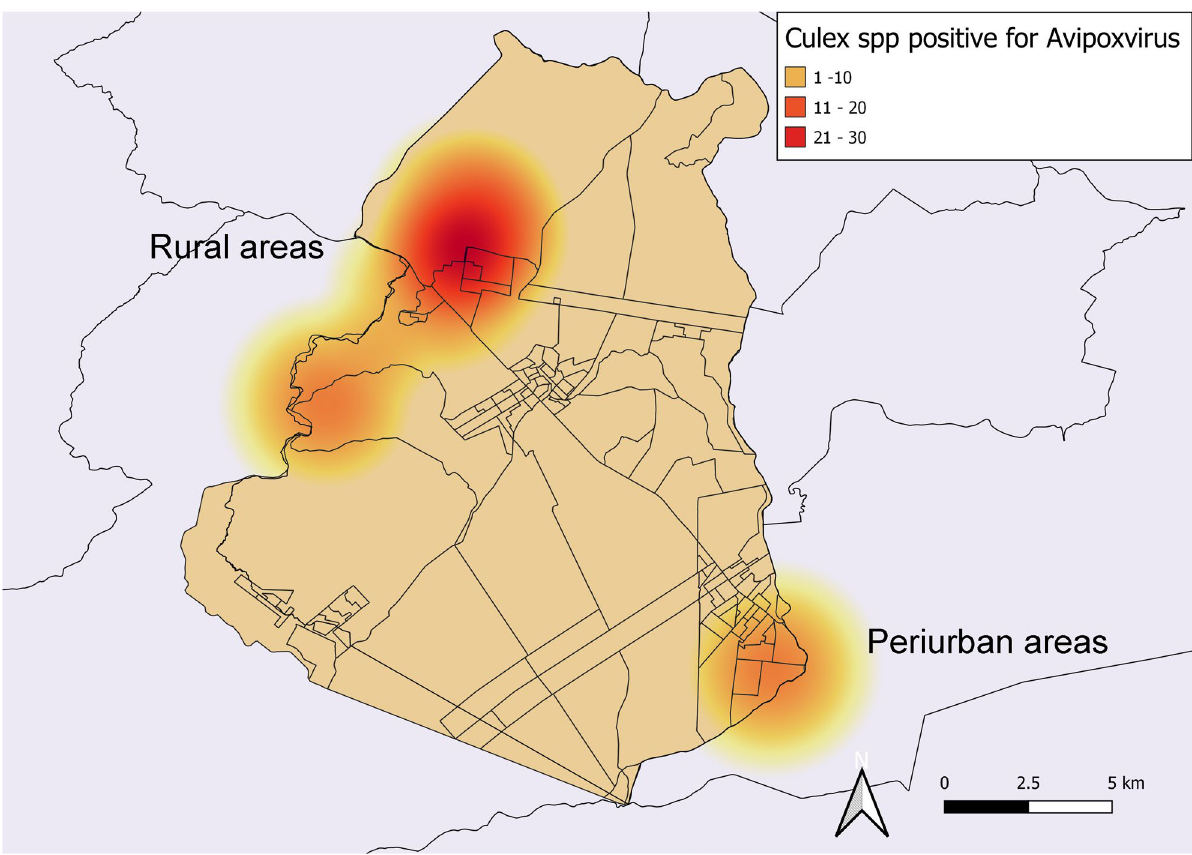
Figure 2. Kernel map showing the concentration of Culex spp. positive for Avipoxvirus in rural and peri-urban areas in Seropedica, RJ. Map created in QGIS software 3.22.8 ’Białowieża’ (https:// qgis. org/ pt_ BR/